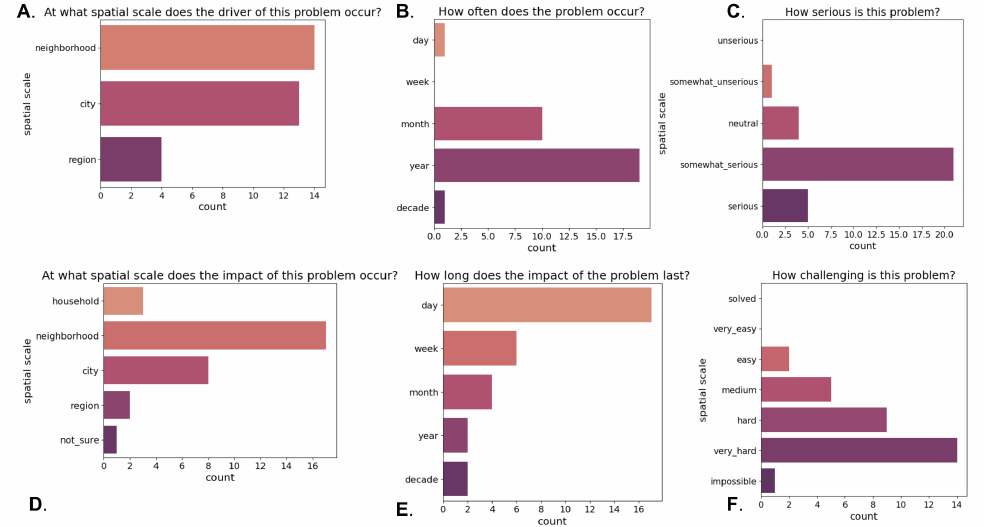
Figure 8. Stakeholders identified 31 stormwater problem areas addressing issues surrounding the spatial-temporal scale of the problems occurring ( A , B ) and the socio-environmental impact of the problem ( D , E ). Additionally, stakeholders identified their perceptions of the seriousness of the problem ( C ) and how challenging the problem is to solve ( F